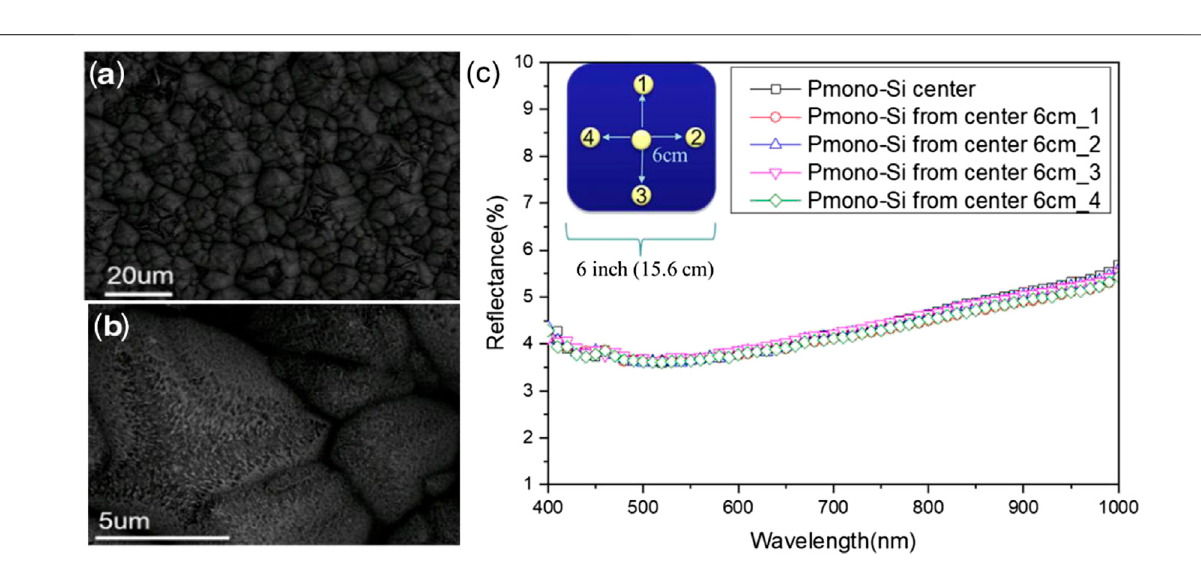
Frontiers in Physics |